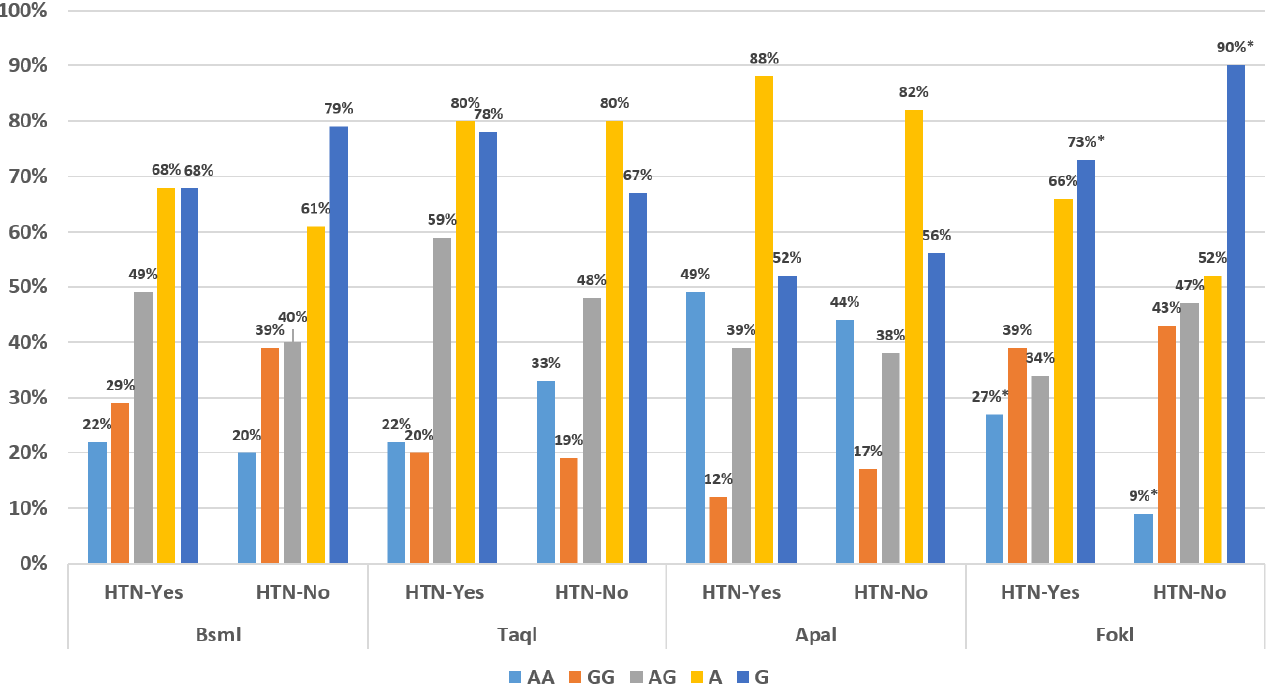
Figure 4. Genotypes and allele percentage distribution of four VDR gene polymorphisms in obese subjects compared to normal weight (N weight) subjects.